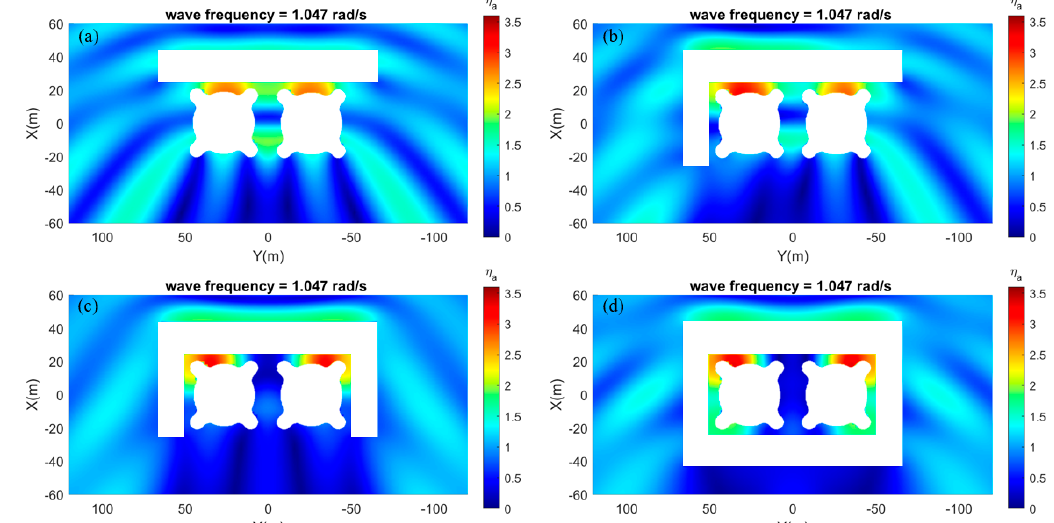
Figure 18. Amplitude of free surface elevations around the floating tanks and the breakwaters in 0 deg wave direction, with wave frequency of 1.047 rad/s for ( a ) conventional single floating breakwater, ( b ) L-shape, ( c ) U shape, and ( d ) barge frame